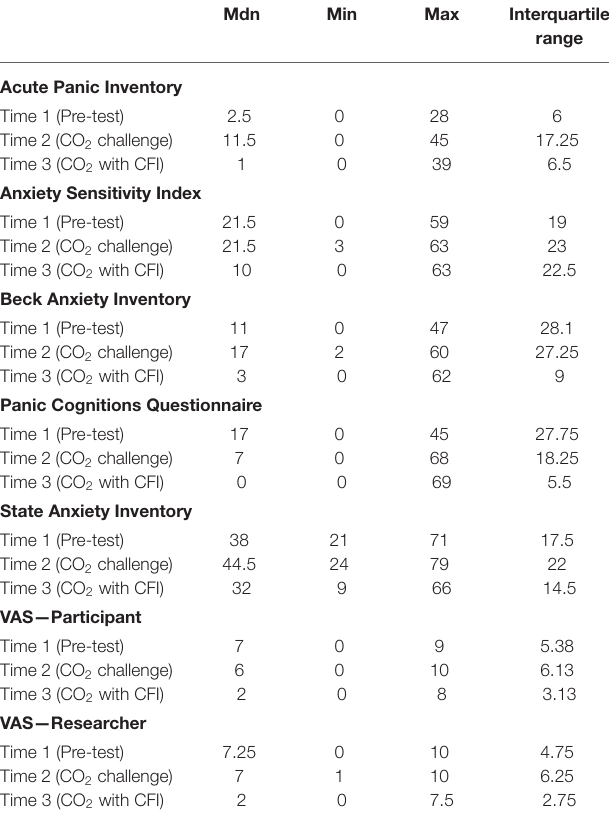
TABLE 7 | Medians, minimum, maximum and interquartile ranges for psychological measures at time 1, time 2, and time 3. Mdn Min Max Interquartile